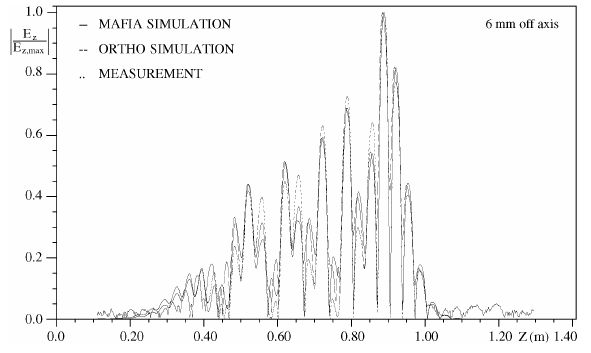
FIG. 10. Longitudinal (cid:69) field of mode #15.